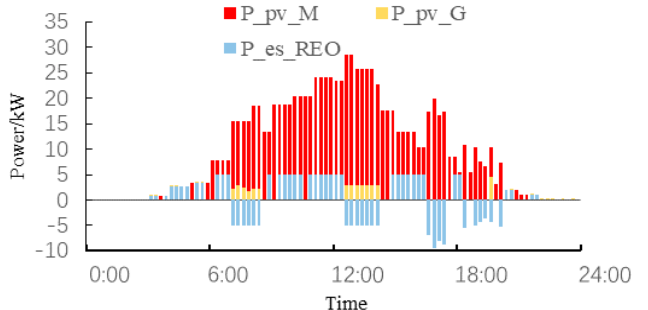
Figure 6. Electric power output distribution of REO.